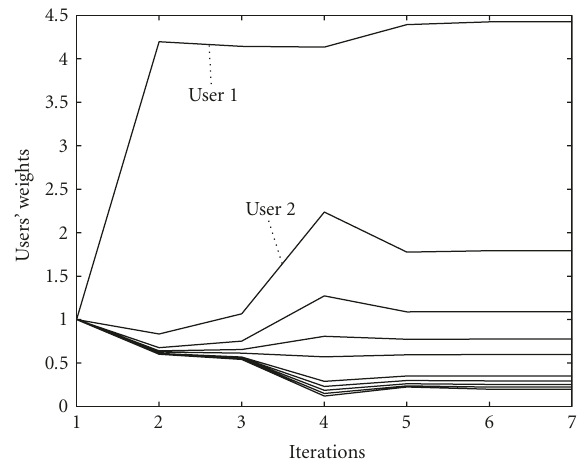
Figure 6: Convergence of the weight vectors for fair scheduling in the 10-users channel using a conventional Gauss-Newton method. The average SNR is ρ = 10dB.